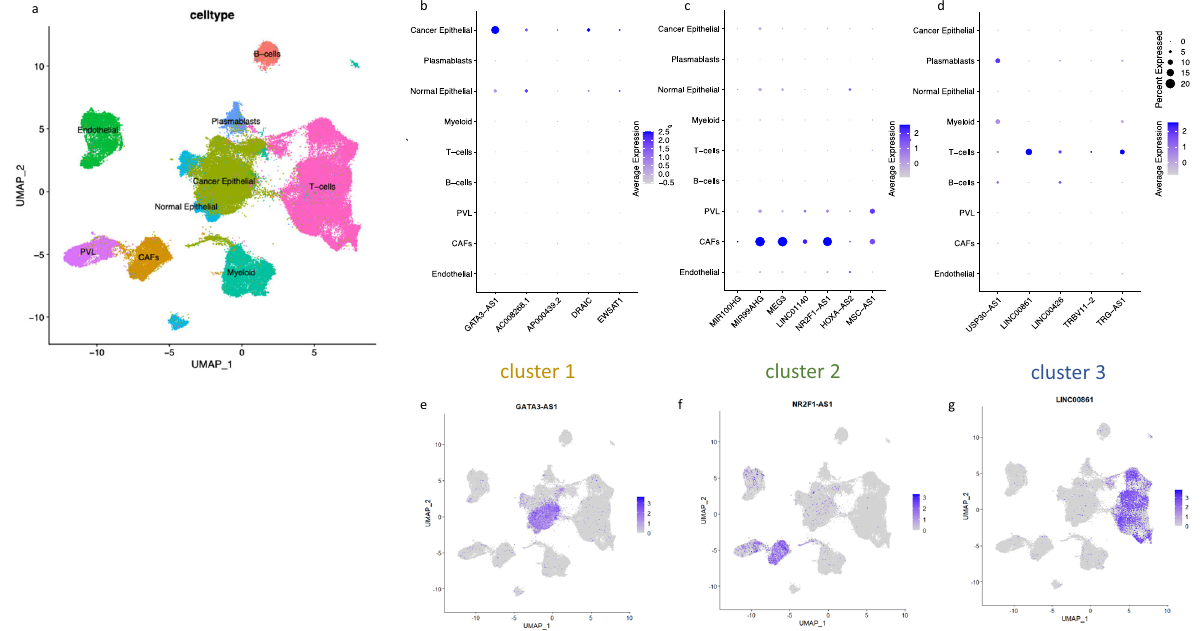
Fig. 3 lncRNA expression in single cell RNA-seq data. a UMAP of 94357 single cells from breast tumours colour-coded according to cell types. b , d Dot plot of lncRNAs (found in the scRNA-seq data set) with highest glm coef fi cient associated with the characteristics of each cluster, i.e ESR1 mRNA (Cluster 1), fi broblast score (Cluster 2), lymphocyte score (Cluster 3). Size of the dot represents the percentage of cells expressing the lncRNA, while the colour of the dot re fl ects the average expression in each of the UMAP-cell-type-cluster identi fi ed. Cluster 1 lncRNAs b , cluster 2 lncRNAs c , and cluster 3 lncRNAs d . e – g Expression of one high ranking lncRNA from each lncRNA cluster plotted on the scRNA-seq UMAP. Cluster 1-lncRNA: GATA3-AS1 c , cluster 2-lncRNA: NR2F1-AS1 d , and cluster 3-lncRNA: LINC0861 e . Colour gradient (purple) represents Log normalized counts using scale.factor =